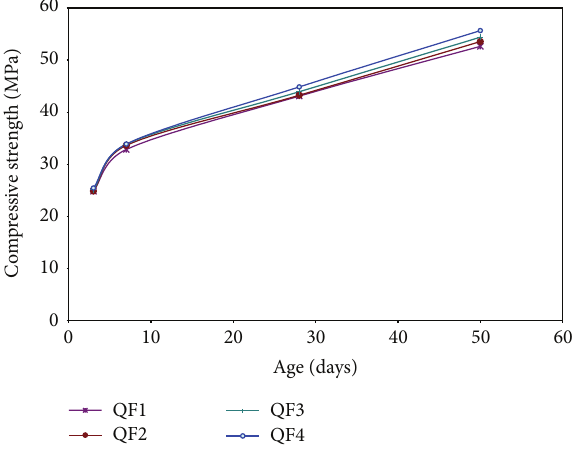
Figure 4: Compressive strength test results for QF series.